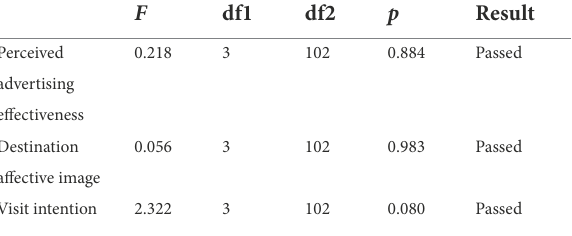
TABLE 2 Levene’s test for homogeneity of error variance.